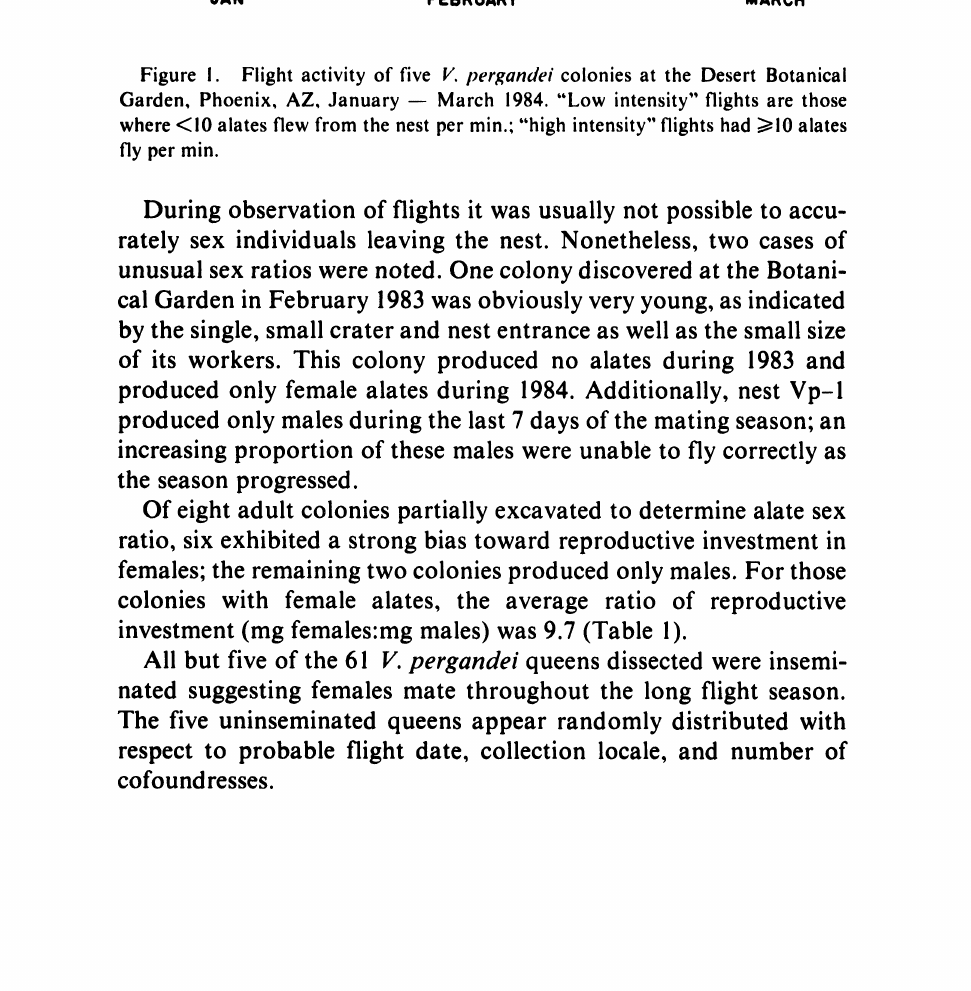
Figure I. Flight activity of five V. pergandei colonies at the Desert Botanical Garden, Phoenix, AZ, January March 1984. "Low intensity" flights are those where <10 alates flew from the nest per min.; "high intensity" flights had >10 alates fly per